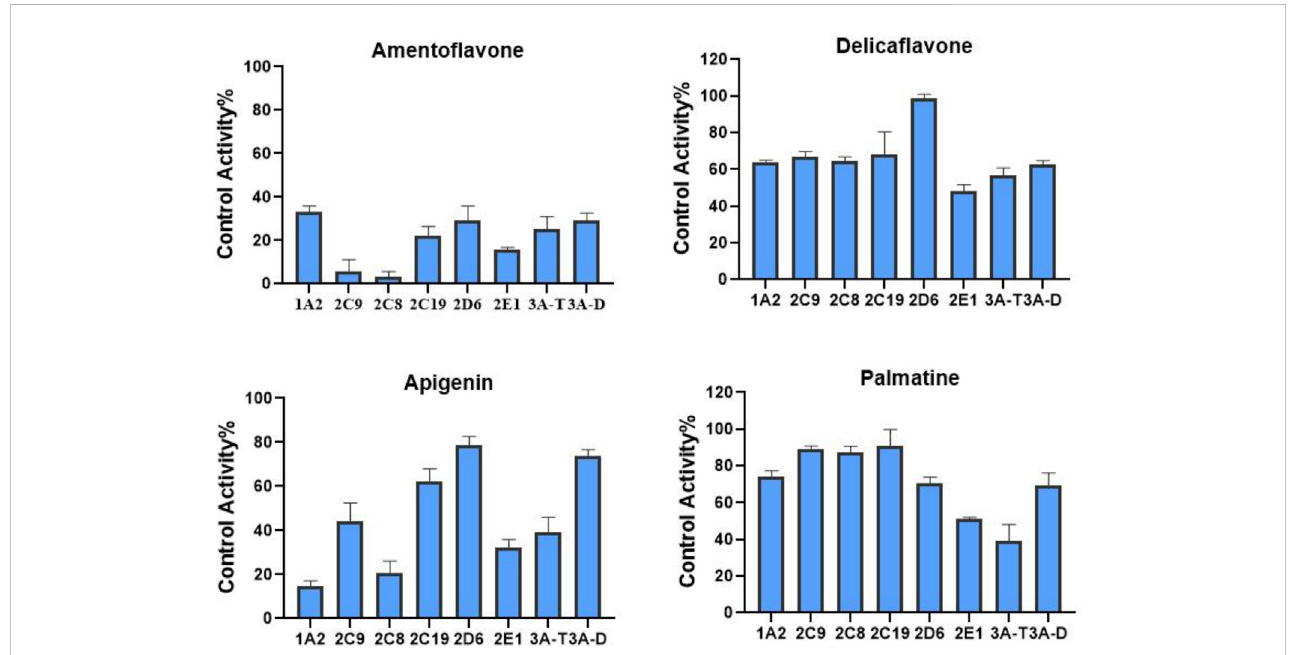
FIGURE 4 Inhibition of CYP enzymes by Amento fl avone, Delica fl avone, Apigenin, and Palmatine at 10 μ M. Inhibition Activity was expressed as a percentage of remaining activity compared to a control test without enzyme inhibitor. Note: 3A-T, CYP3A (Testosterone); 3A-D, CYP3A (Dextromethorphan).